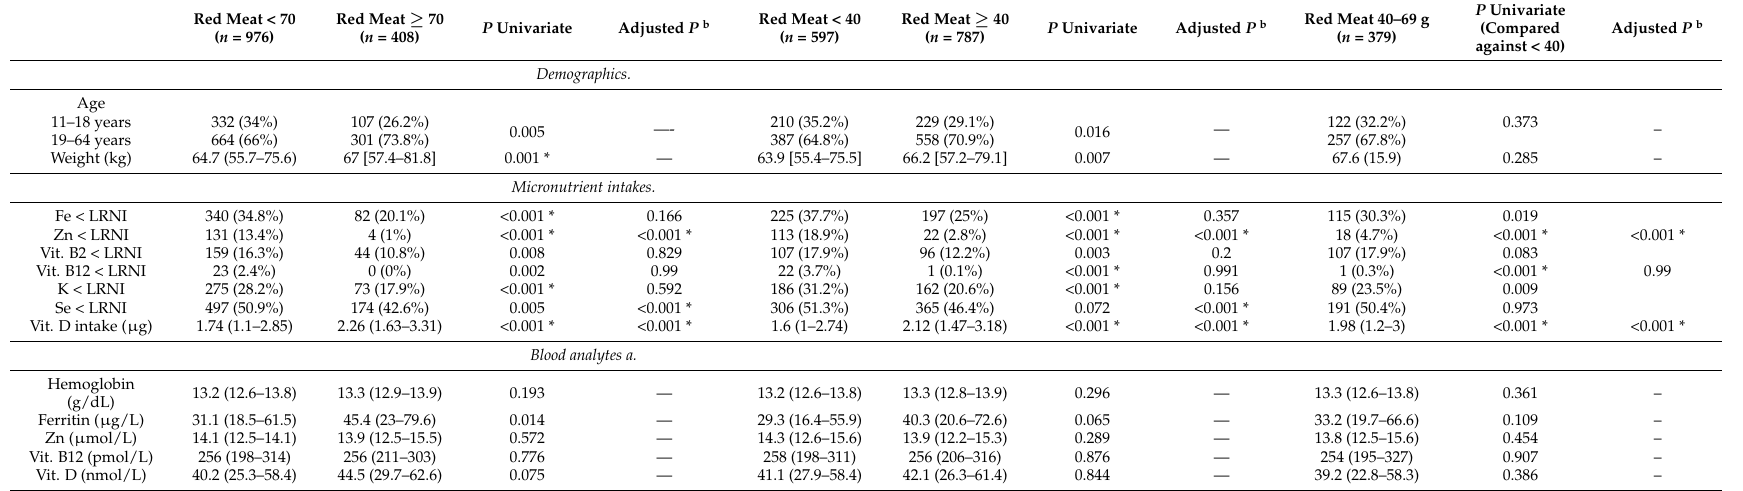
Table 2. Different red meat intakes in relation to micronutrient intakes and status in UK